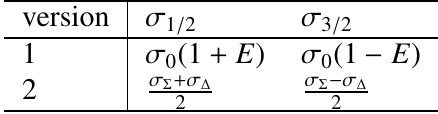
Table 3: Overview of di ff erent versions used to extract two helicity state cross section components; where, σ Σ = σ + σ σ = σ − σ Δ 1 / 2 3 / 2 and 1 / 2 3 / 2